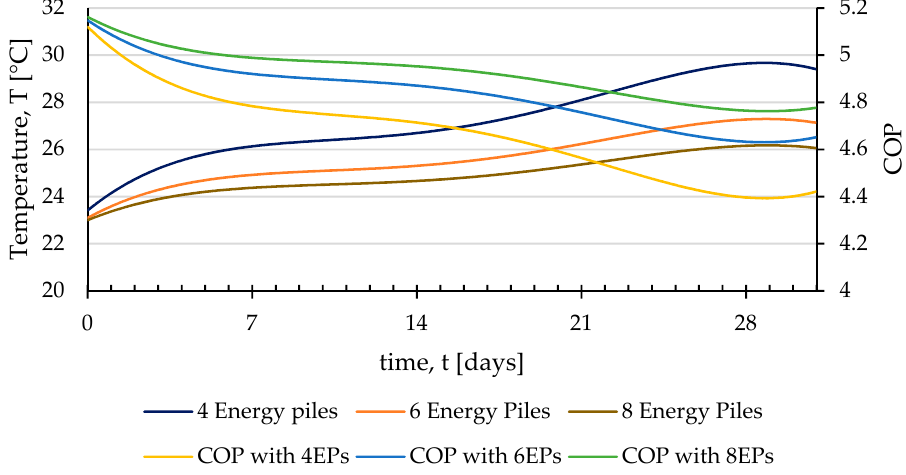
Figure 9. Outlet temperatures and COPs for 4, 6, and 8 energy piles for the month of July.